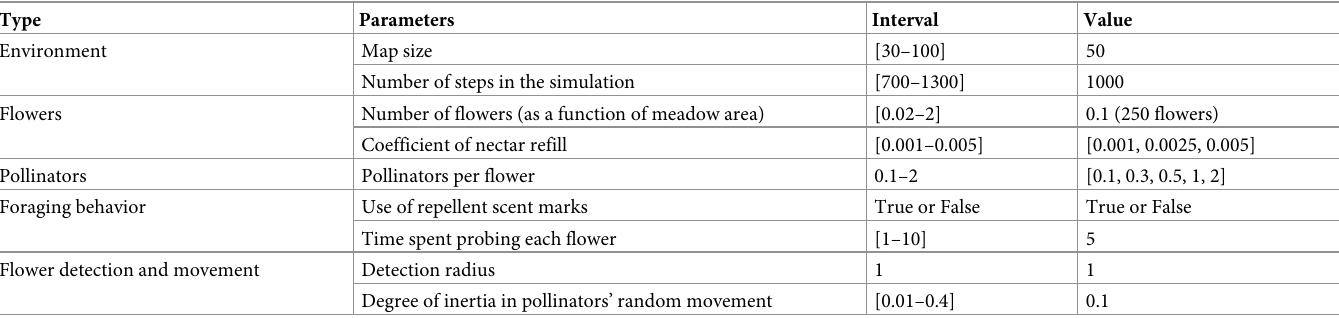
Table 1. List of the model parameters and their variation